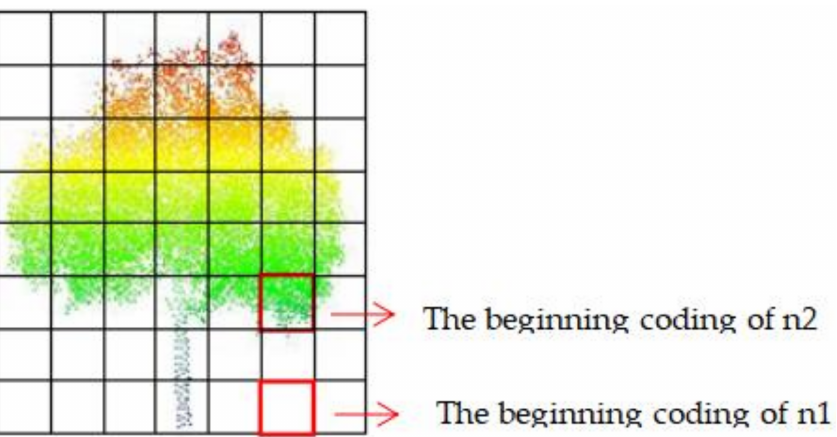
Figure 5. Coding diagram; the codes in the figure operate in vertical column